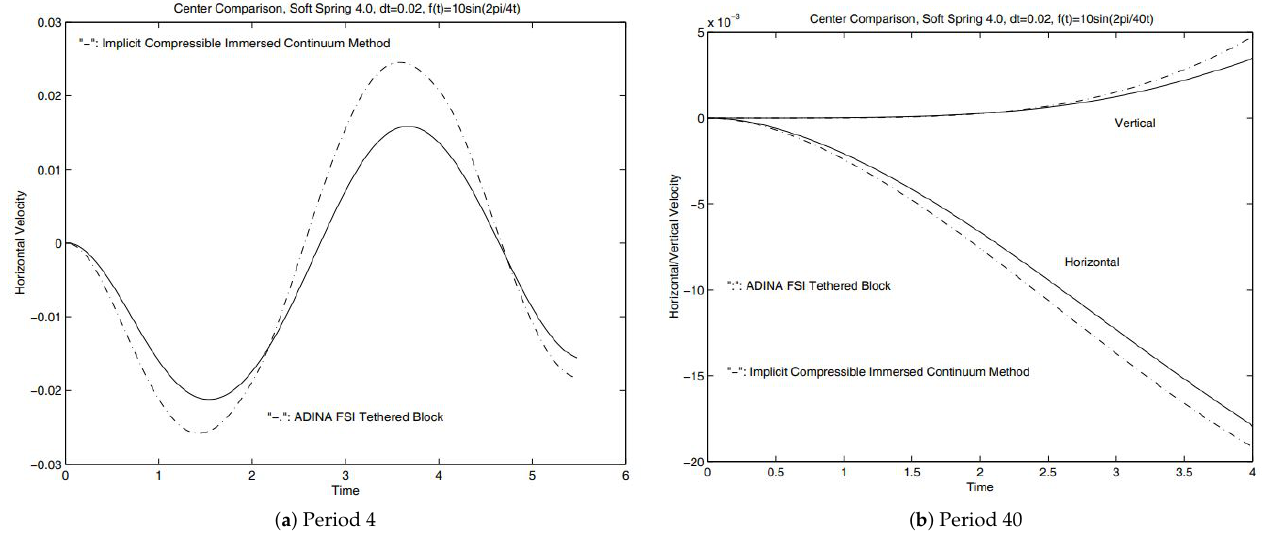
Figure 10. Extra numerical dissipation due to immersed